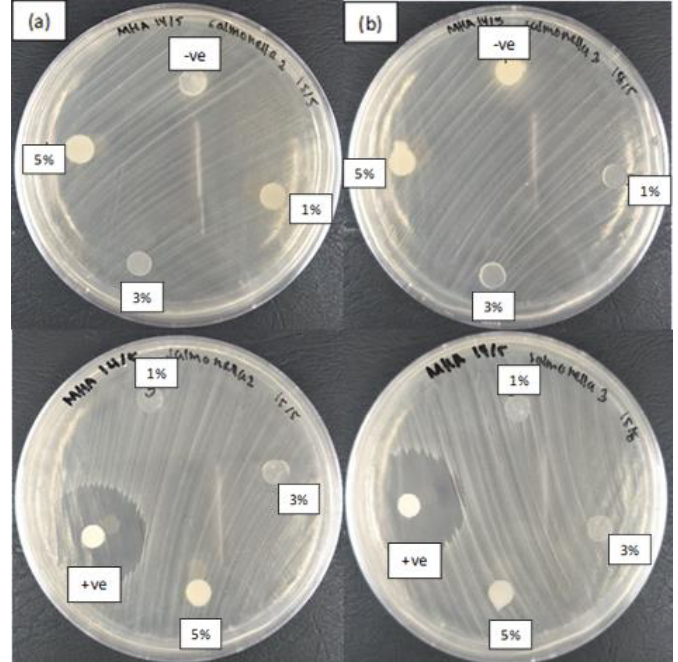
Figure 8. Zone of inhibition of starch films incorporated with different concentrations of synthesized ZnO NPs synthesized at column ( a ) with heating (60 °C) and column ( b ) without heating (28 °C) against Gram-negative Salmonella enterica serotype Choleraesuis. Film without ZnO NPs acted as negative control (“-ve”), while streptomycin antibiotic as positive control (“+ve”). Table 2. Antibacterial activity of synthesized ZnO NPs against Gram-positive and Gram-negative bacteria, measured as the diameter of the inhibition zone. Concentration of ZnO NPs in Zone of Inhibition (mm) Starch Films Salmonella enterica serotype Bacillus subtilis UPMC 1175